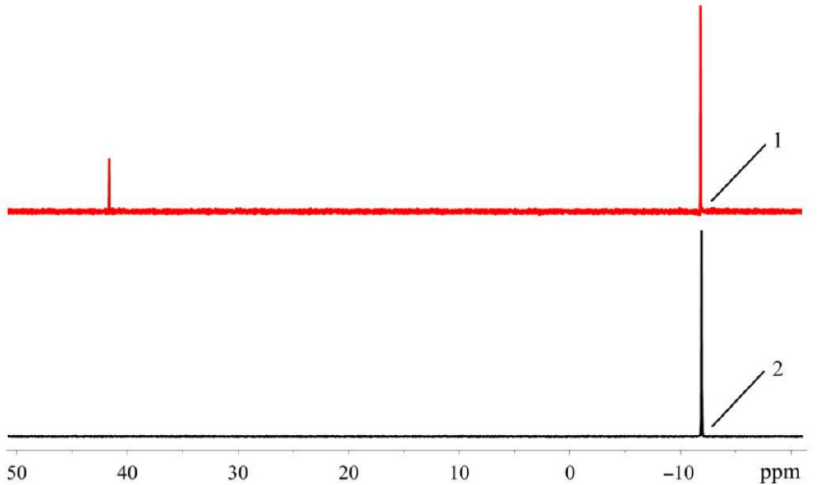
Figure 16. 31 P-NMR spectra of XPhos in unpurified commercial (1) and freshly distilled THF